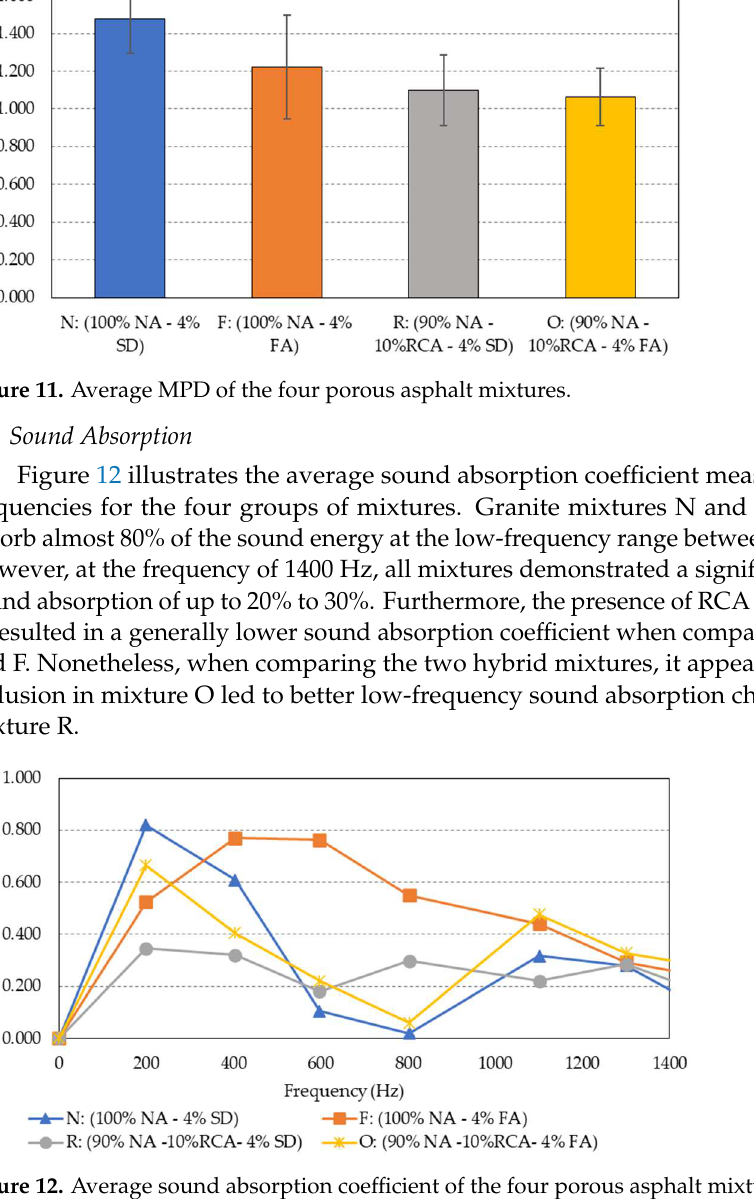
Figure 12. Average sound absorption coefficient of the four porous asphalt mixtures.